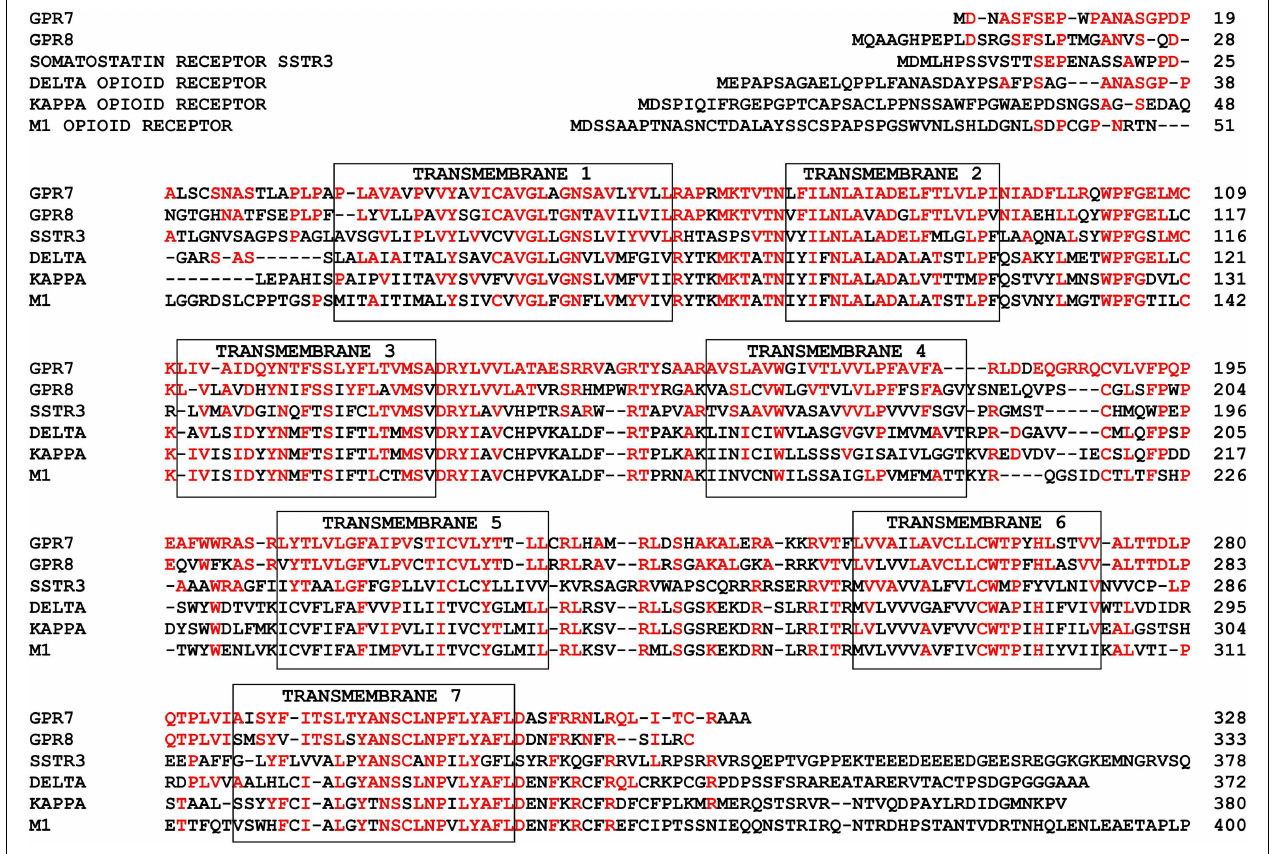
FIGURE 2 | Primary structures of NPBWR1/NPBWR2 compared to somatostatin and opioid receptors. Conserved amino acid residues are shown in red. Each transmembrane domain is boxed. Modified from Hondo et al.